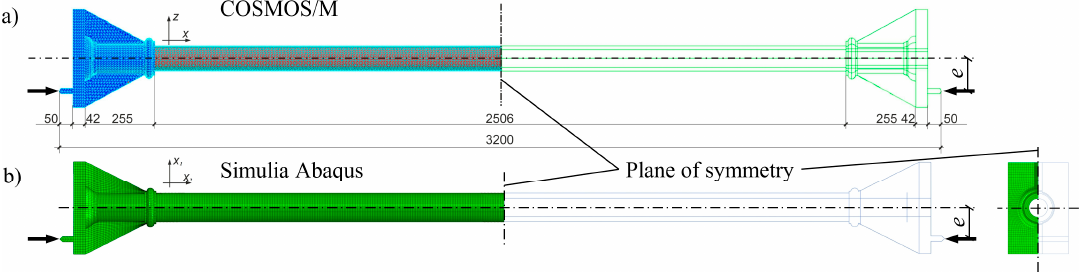
Figure 4. Scheme of the column’s loading. FE mesh in: ( a ) COSMOS/M; ( b ) Simulia Abaqus.